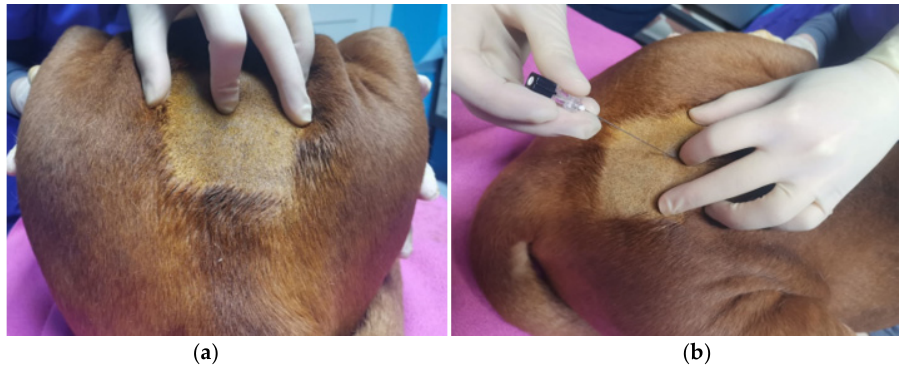
Figure 5. Identification ( a ) and insertion ( b ) of the needle into the LS.